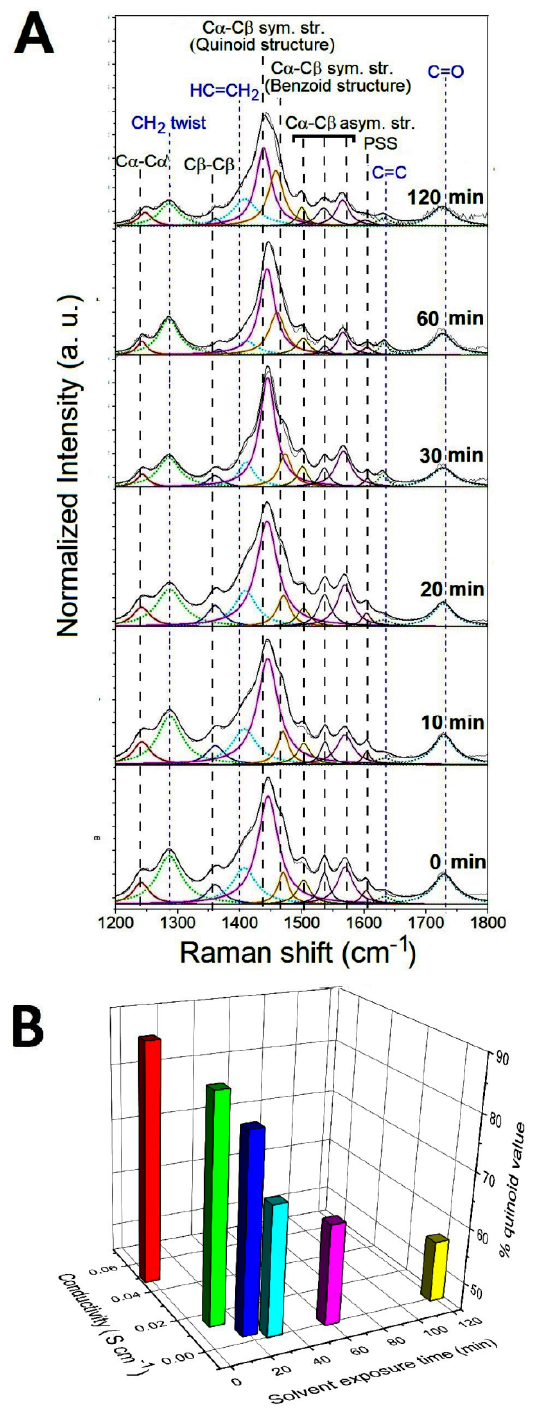
Figure 8. ( A ) Raman spectra of PEGDA:PEDOT samples exposed to acetone vapors for 0, 10, 20, 30, 60 and 120 min. ( B ) Conductivity and % quinoid value as a function of the vapor exposure time.